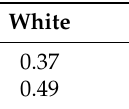
Table 10. Optimal coefficients for fitting the color